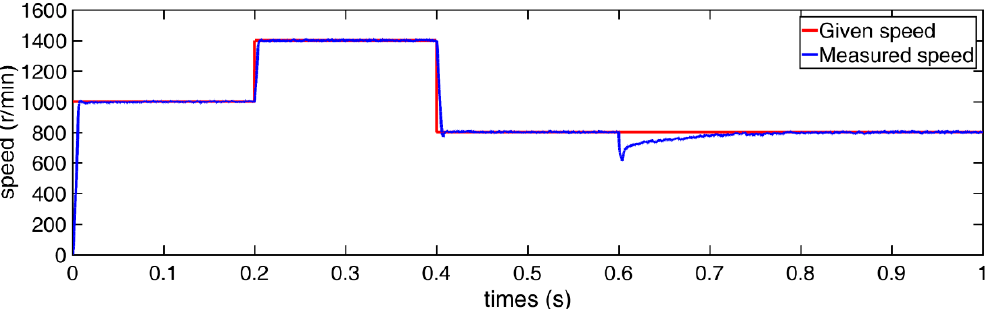
Figure 5. Speed waveform of two-stator HEPMSM.